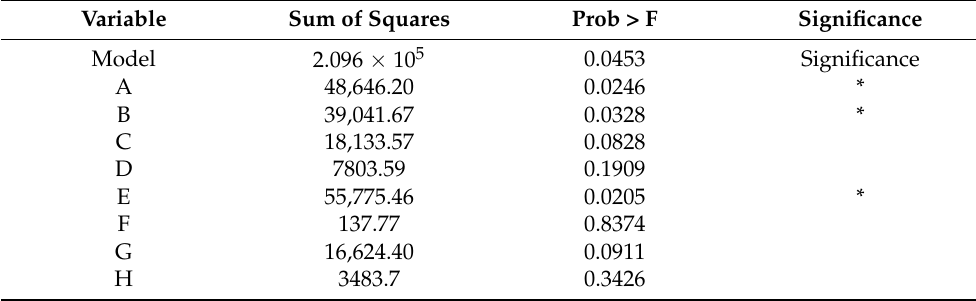
Table 7. Analysis of variance of the response surface quadratic model for GA4 production.